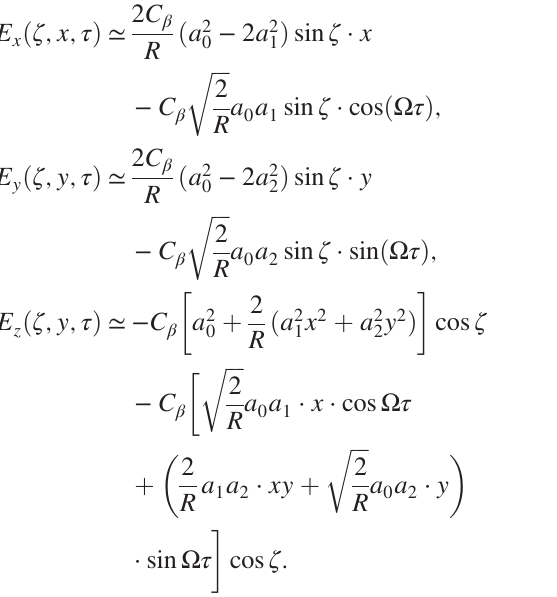
FIG. 2. (a), (b) Projection of the transverse wakefield E generated by two different modes without and with the condition (12), as a function of time τ on ˆ x ˆ z plane. The dashed white lines show the trajectories of an electron in the wakefield; (c), (d), (e), (f) Slices of the transverse wakefield E different modes with the condition (12), on ˆ x ˆ y plane at four different propagation positions, τ ¼ 2269 , 2432, 2512, 2592, respectively; (g), (h), (i), (j) Slices of transverse wakefield E generated by three different modes with the condition (12), at four different propagation positions, τ ¼ 2045 , 2432, 2816, 3200,